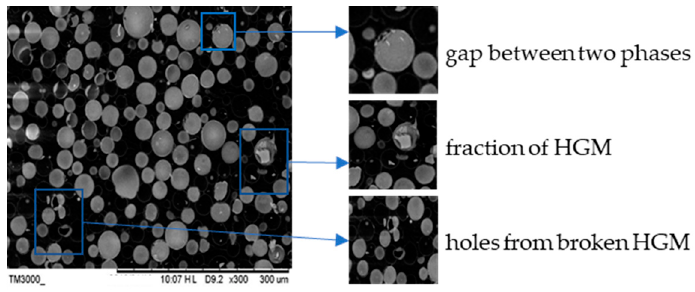
Figure 2. The cross-sectional morphology of AG-80 epoxy resin-based buoyancy material with a 55% volume fraction of hollow glass microspheres (HGM.).